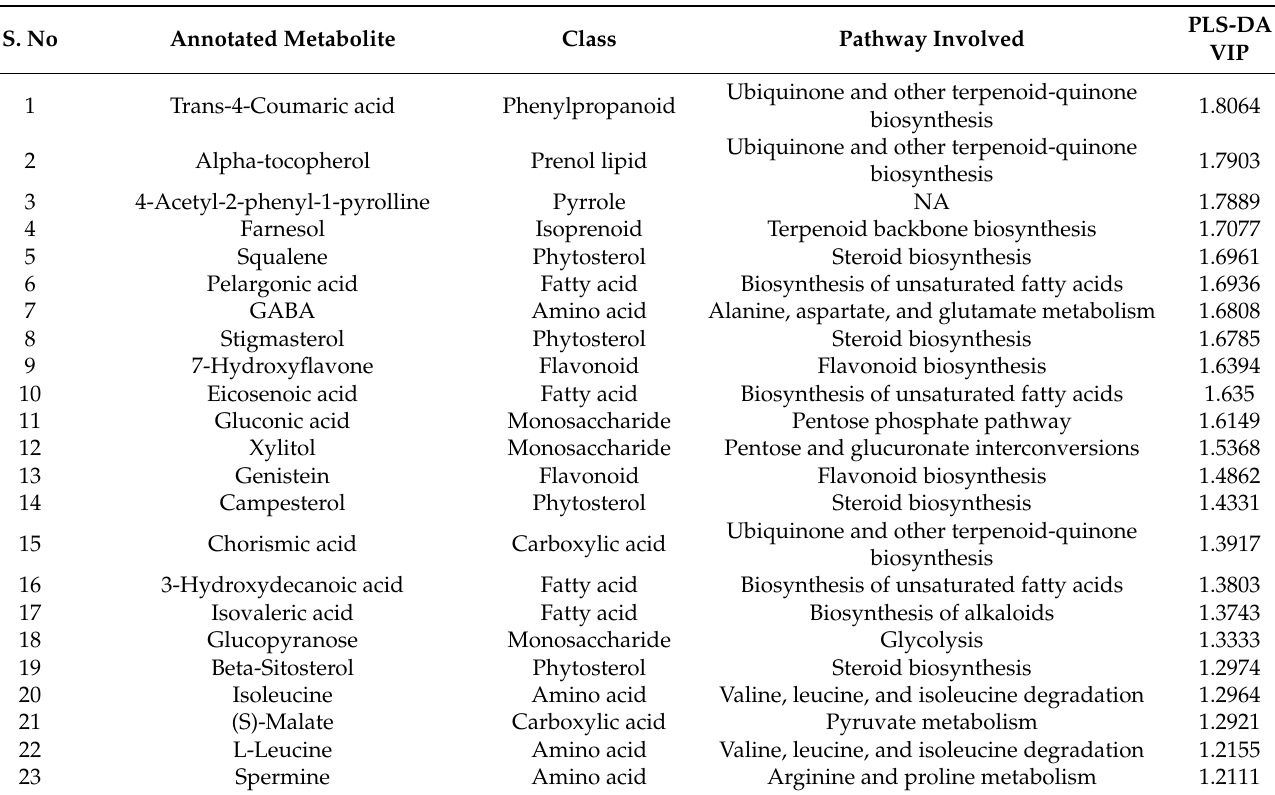
Figure 5. Partial least-square discriminant analysis discriminating Mappillai Samba and CBMAS 14065 based on the grain metabolome (cumulative variance of 83.7%; 69.3% and 14.4% variance explained by components 1 and 2, respectively). Table 2. List of the significant metabolites differentiating the grains of Mappillai Samba and CBMAS 14065 based on the VIP scores of the PLS-DA.